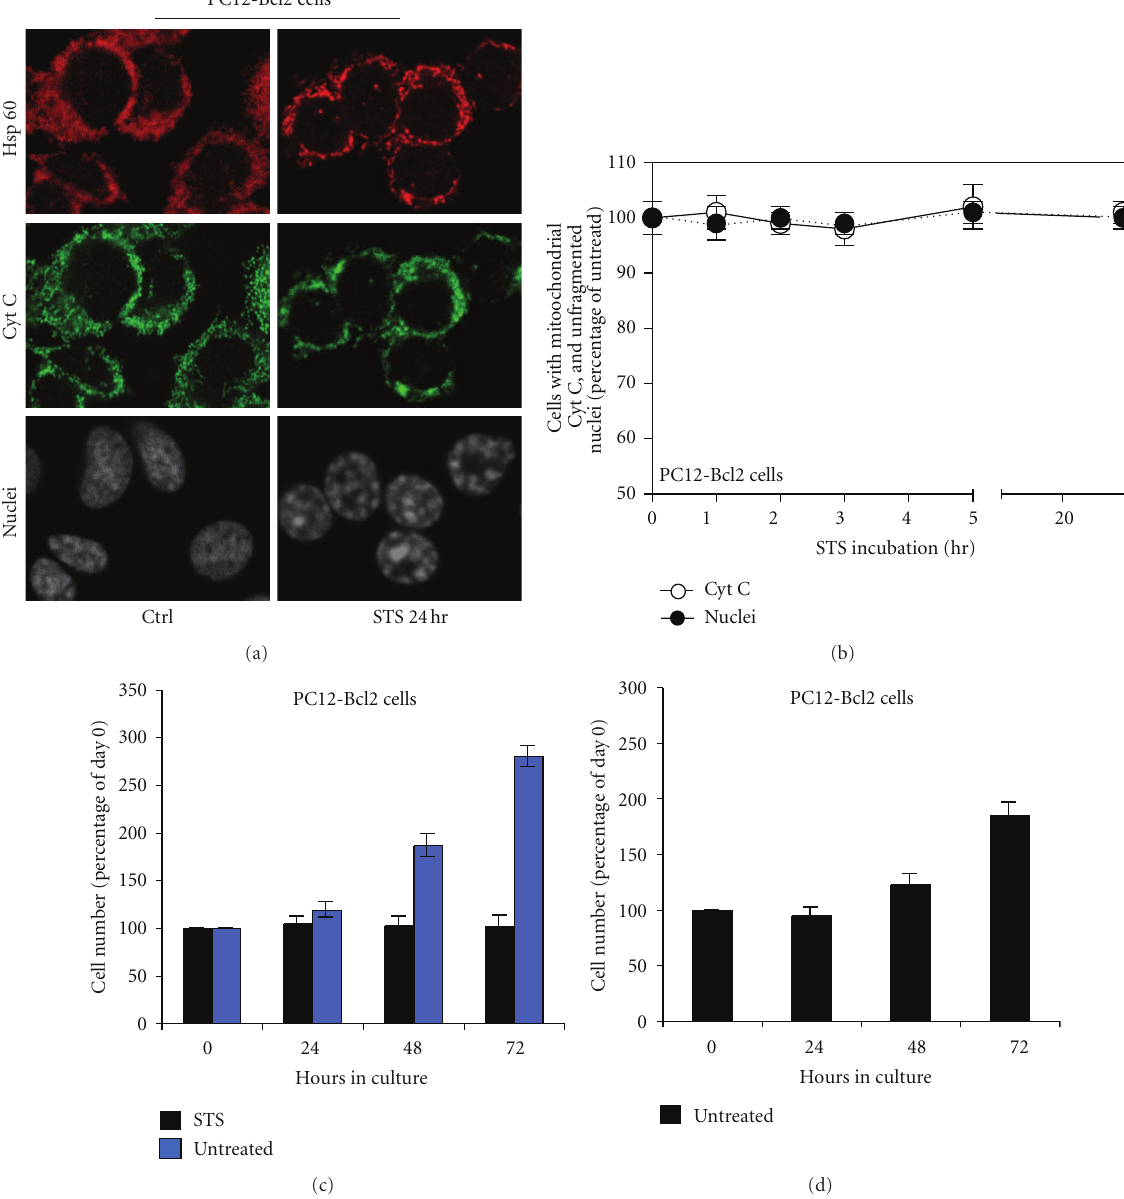
Figure 3: Cytochrome c localization and nuclear changes in STS-treated PC12-Bcl-2 cells. (a) Triple labeling confocal immunofluorescence microscopy of PC12-Bcl-2 cells untreated (Ctrl) and 2 μ M STS-treated for 24 h (STS 24 h). Pattern of Hsp60 (red), cytochrome c (green), and nuclear staining by SYTO-X (grey) of the same representative fields are shown. (b) Percentage of PC12-Bcl2 cells with mitochondrially localized cytochrome c and percentage of alive PC12-Bcl2 cells treated with STS for the indicated time. Data were calculated in 3 independent experiments for each time point. About 1000 cells were considered for each experiment at each time point. Note that the ordinate scale starts at 50%. (c) For quantification of cell proliferation, the same number of untreated or STS-treated PC12-Bcl2 cells was plated on several dishes and counted at the indicated times. Data were calculated in 3 independent experiments for each time point. (d) For quantification of cell proliferation, the same number of STS-treated PC12-Bcl2 cells were plated on several dishes and counted at the indicated times. At 24h the medium was replaced in order to remove STS. Data were calculated in 3 independent experiments for each time